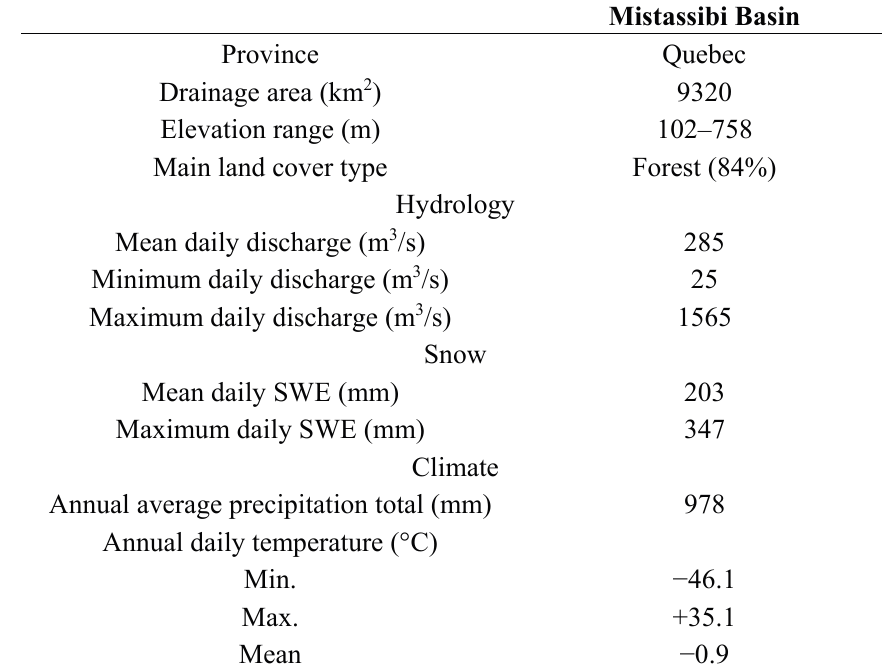
Table 1. General characteristics of the Mistassibi Basin.